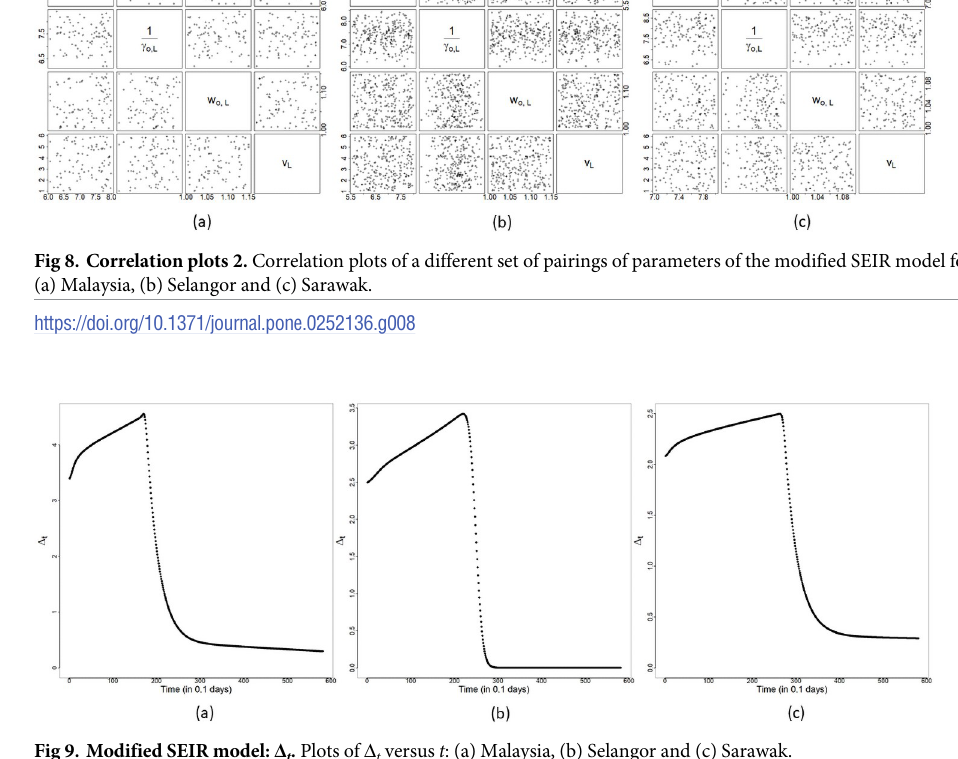
. Plots of Δ versus t : (a) Malaysia, (b) Selangor and (c) Sarawak. t t